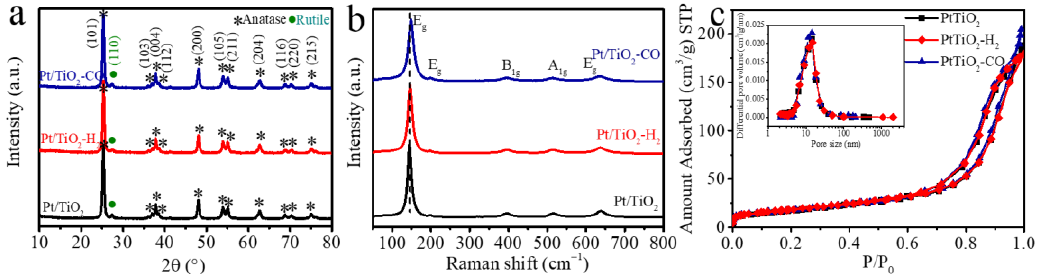
Figure 1. ( a ) XRD patterns, ( b ) micro-Raman spectra, and ( c ) N 2 adsorption–desorption isotherm of Pt/TiO 2 , Pt/TiO 2 -H 2 , and Pt/TiO 2 -CO catalysts.